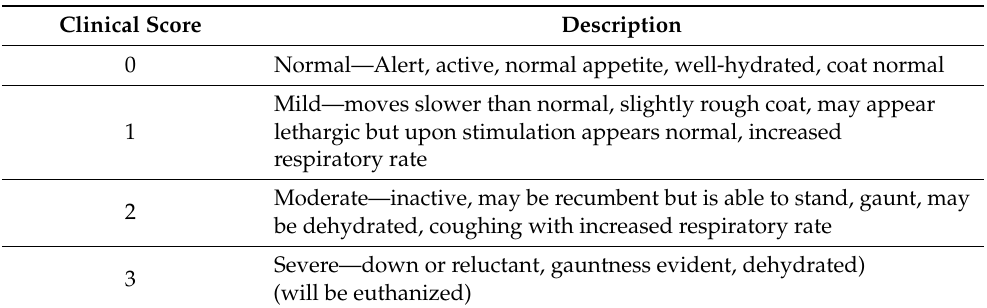
Table 3. Clinical score categorization of pigs used to test core antigen bacterin with an immunostimu- lant on health and performance outcomes when challenged with enteric and respiratory pathogens.